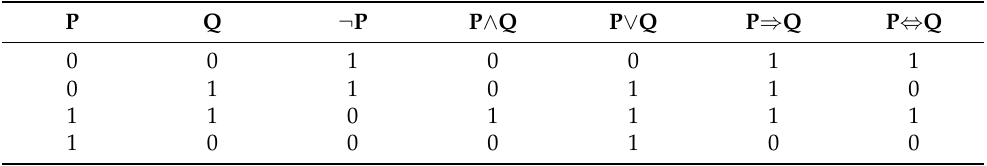
Table 1. Truth table regarding P and Q.